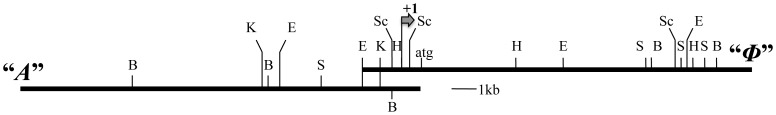
Restriction digest map of the overlapping inserts of genomic clones “A” and “Φ”.The arrow marked by +1 symbolizes the initiation site and the direction of transcription. ‘atg’, marks the site of translation initiation. The scale (1 kb) is shown by a small bar. The enzymes used for mapping are: B: BamHI; E: EcoRI; H: HindIII; K: KpnI; S: SalI; Sc: SacI.